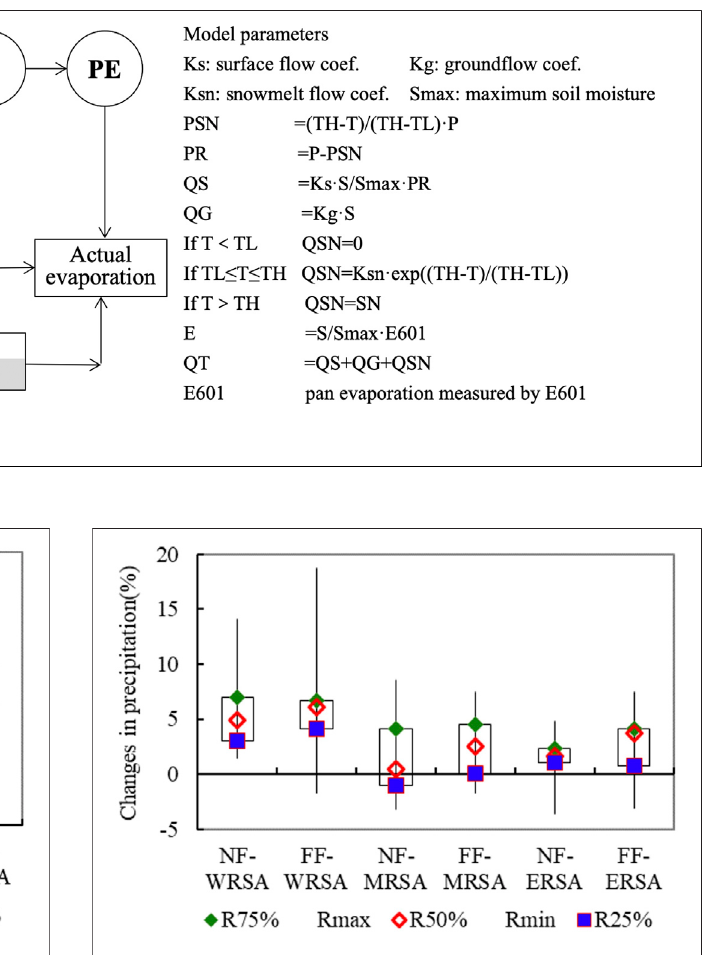
FIGURE 3| Temperature changes in two periods of near future (NF) and farfuture(FF)relativetobaselineof1956 – 2000forallthreesourceareasofthe South-to-NorthWaterDiversionProject(WRSA,MRSA,andERSAdenotethe western route source area, the middle route source area, and the eastern route source area, respectively; same as Figure 4 and Figure 7 ).